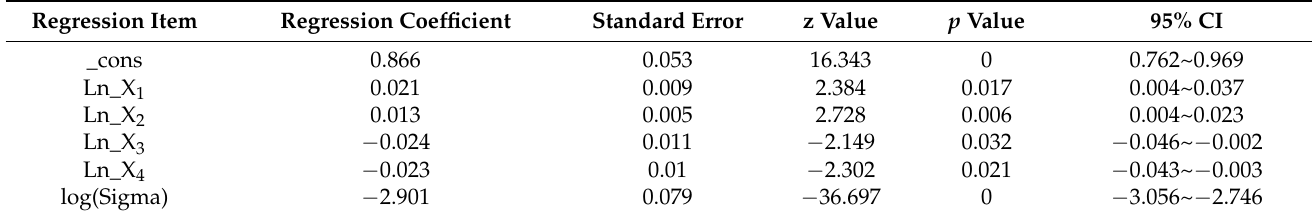
Table 10. Regression analysis results of Tobit model.